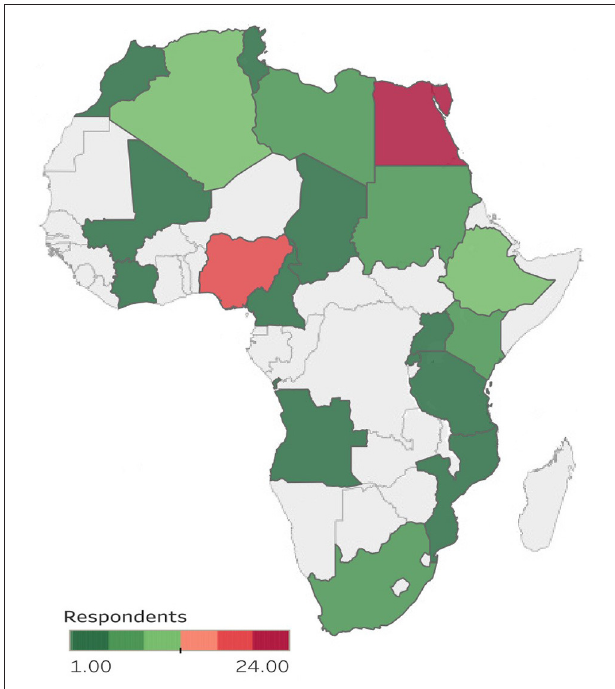
FIGURE 1 | Countries represented in the e-survey and the number of respondents per country.